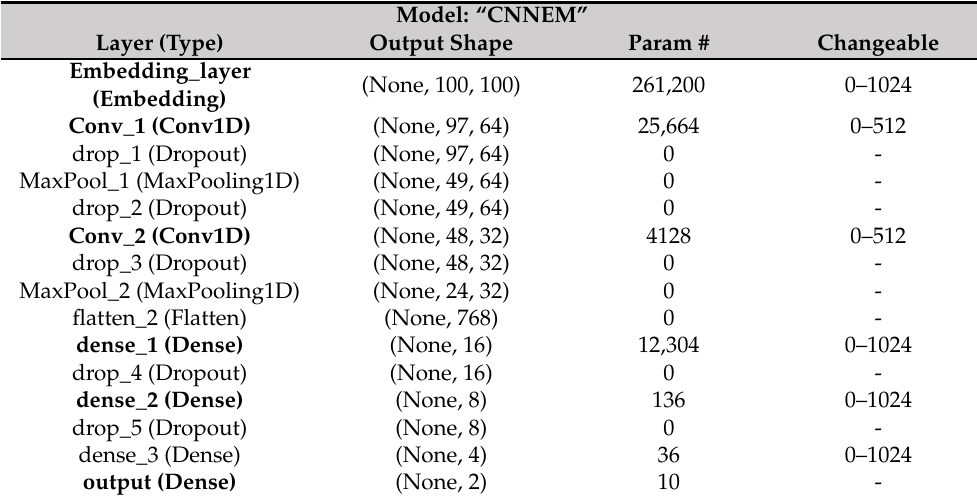
Table 9. Specifications of CNNEM model and its modifiable neurons using proposed BAOVAH approach.